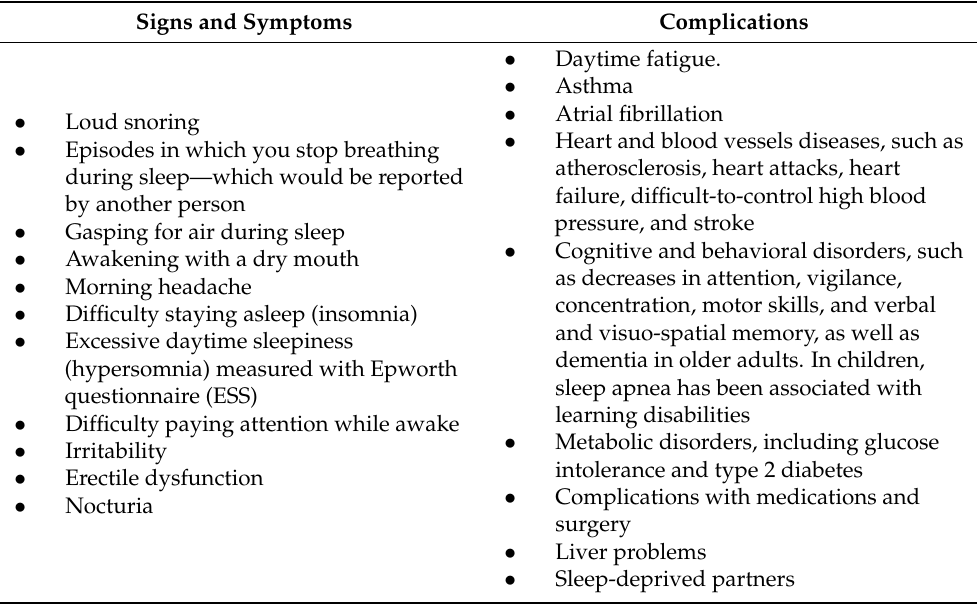
Table 1. Obstructive Sleep Apnea: signs, symptoms, and complications. Signs and Symptoms